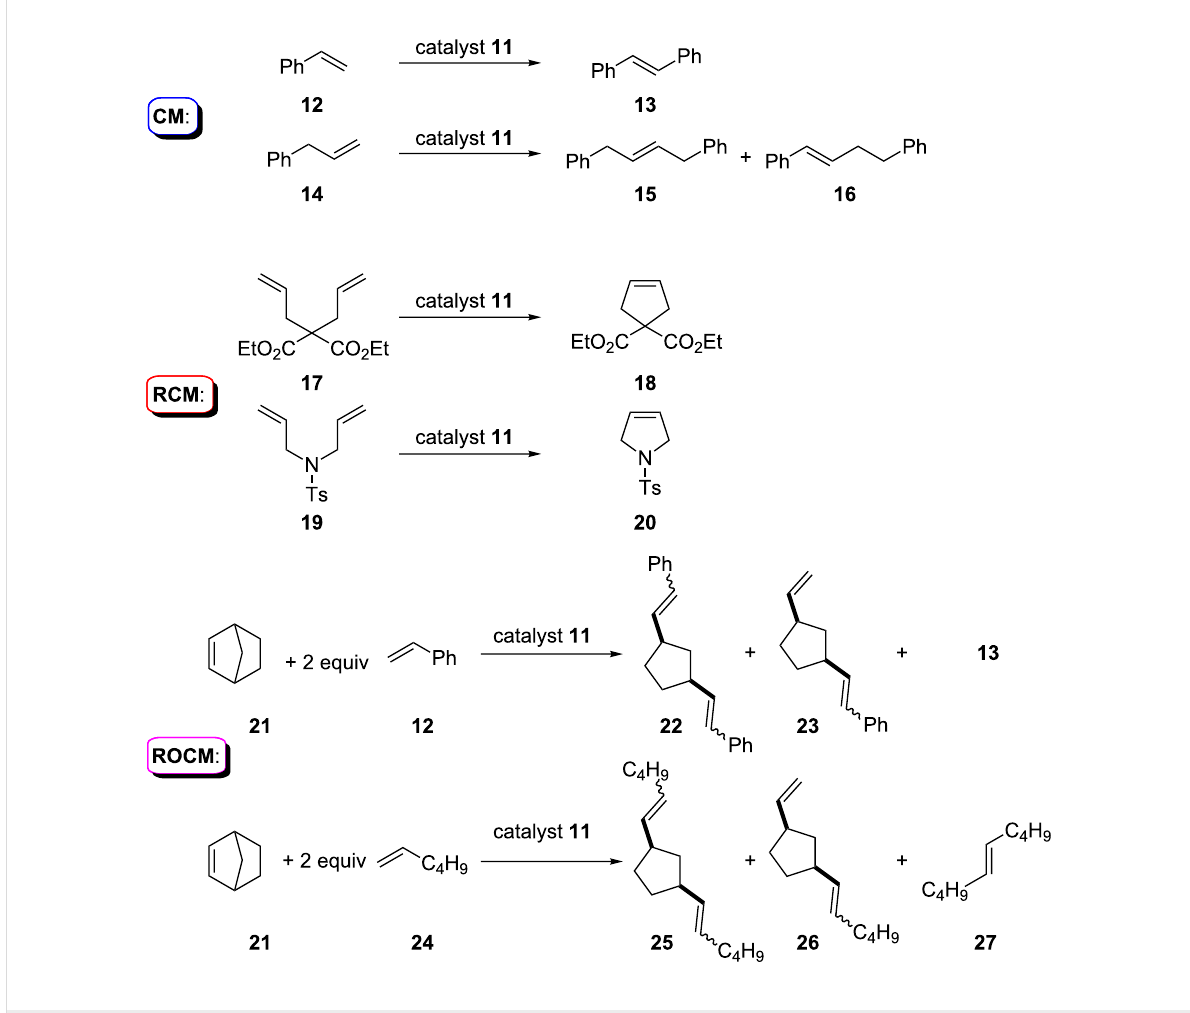
Scheme 6: Catalytic activity of compounds 11 in the metathesis reactions.